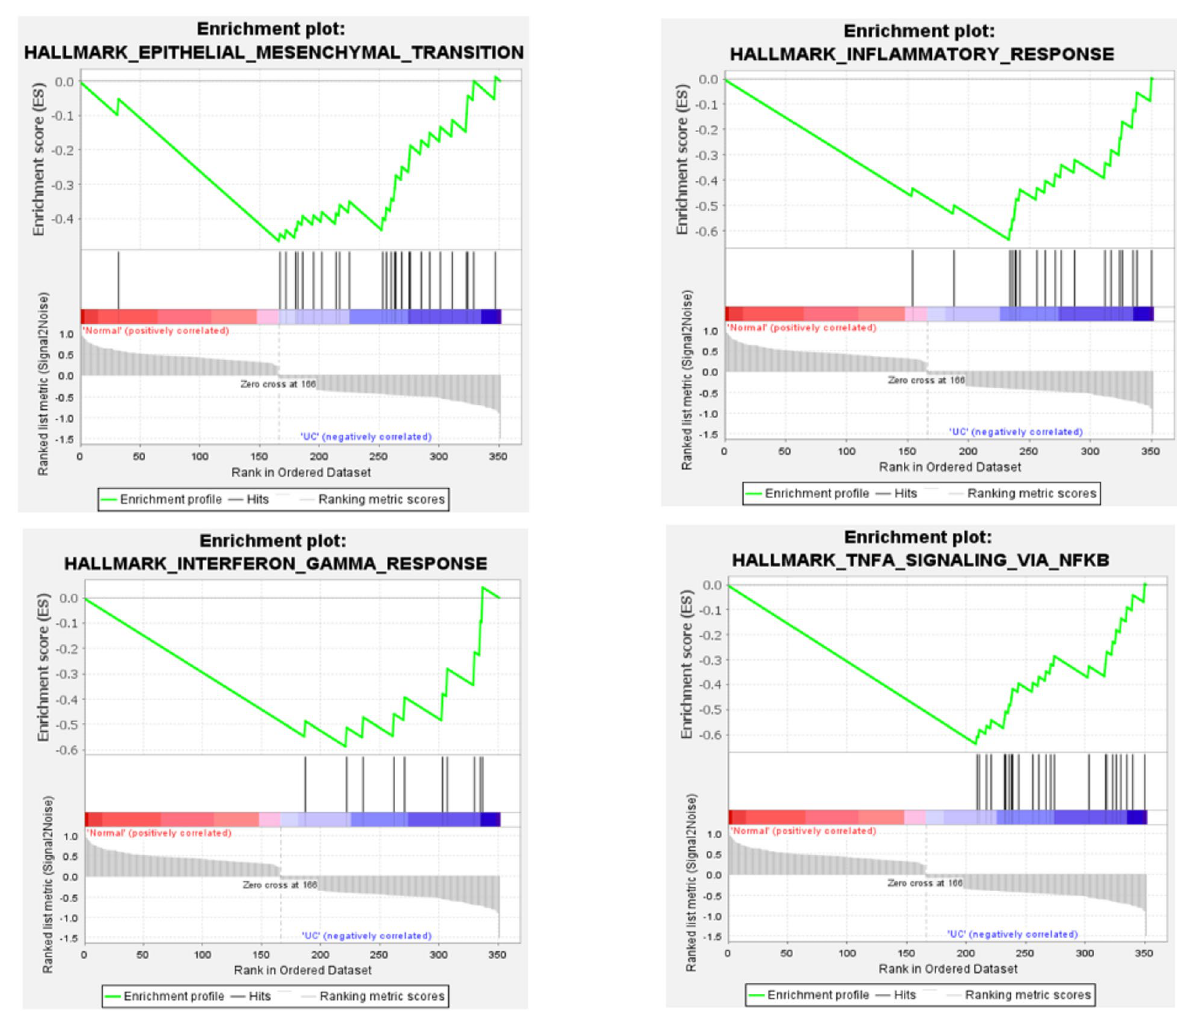
Figure 5. The results of GSEA analysis for DEGs with differential expression in UC compared to